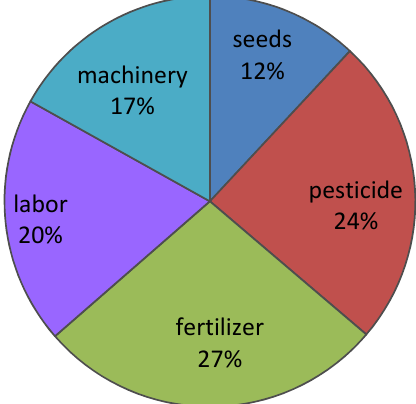
Fig. 2: A pie chart showing the percentage of expense distribution by rice farmers